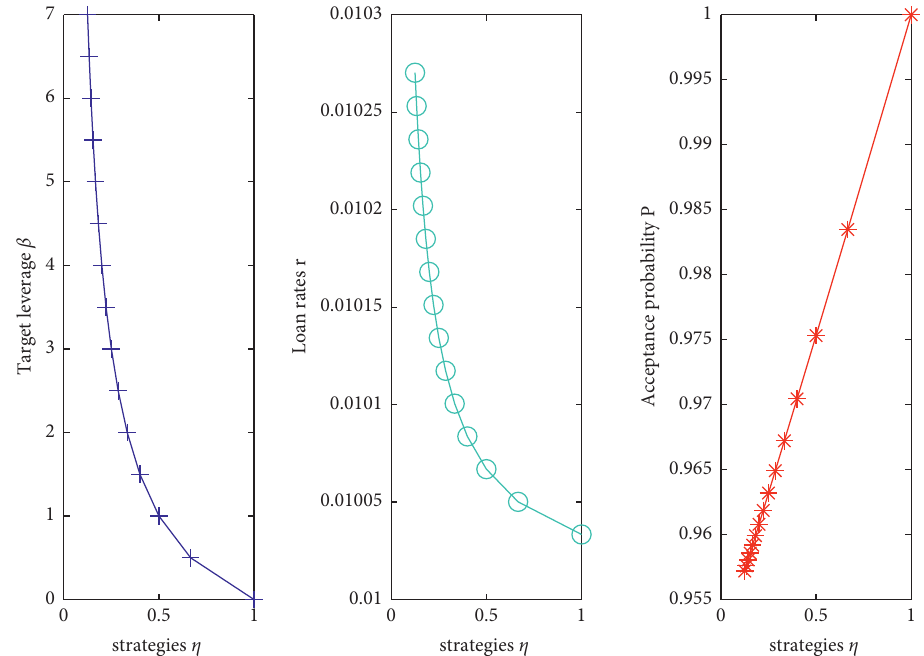
Figure 8: Evolutionary characteristics of target leverage, loan interest, and acceptance probability with strategy.